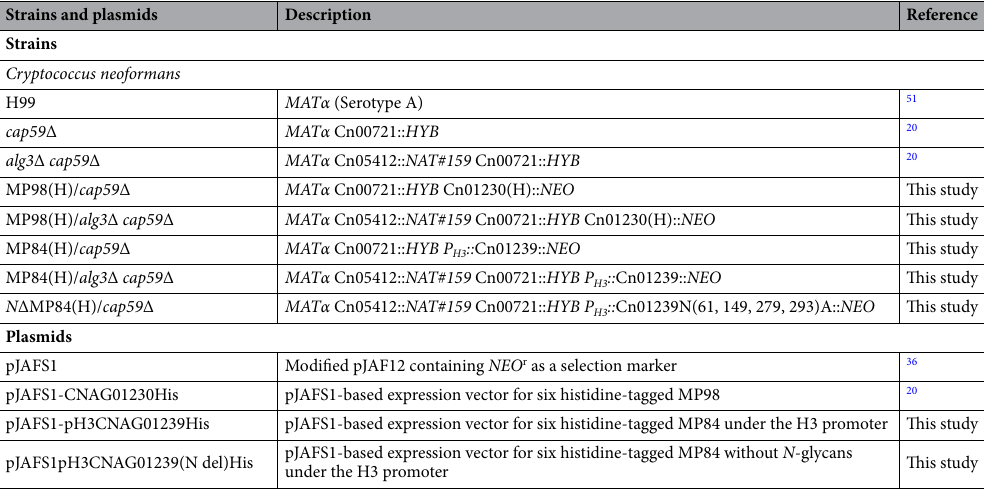
Table 1. List of C. neoformans strains and plasmids used in this